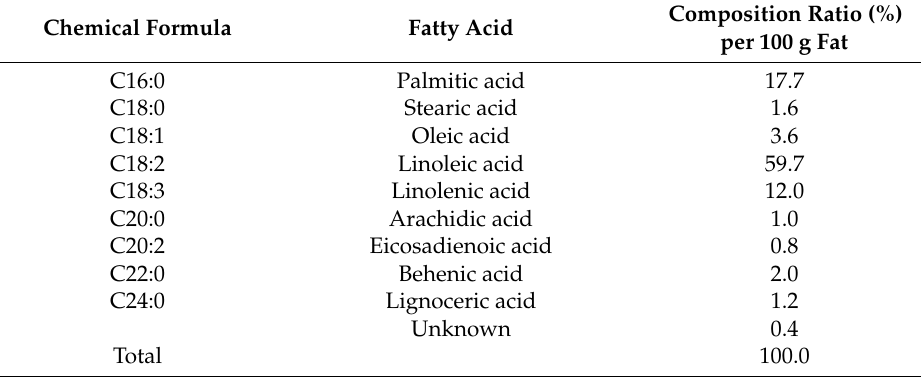
Table 1. Principal components of fatty acid in the skullcap hexane fraction.